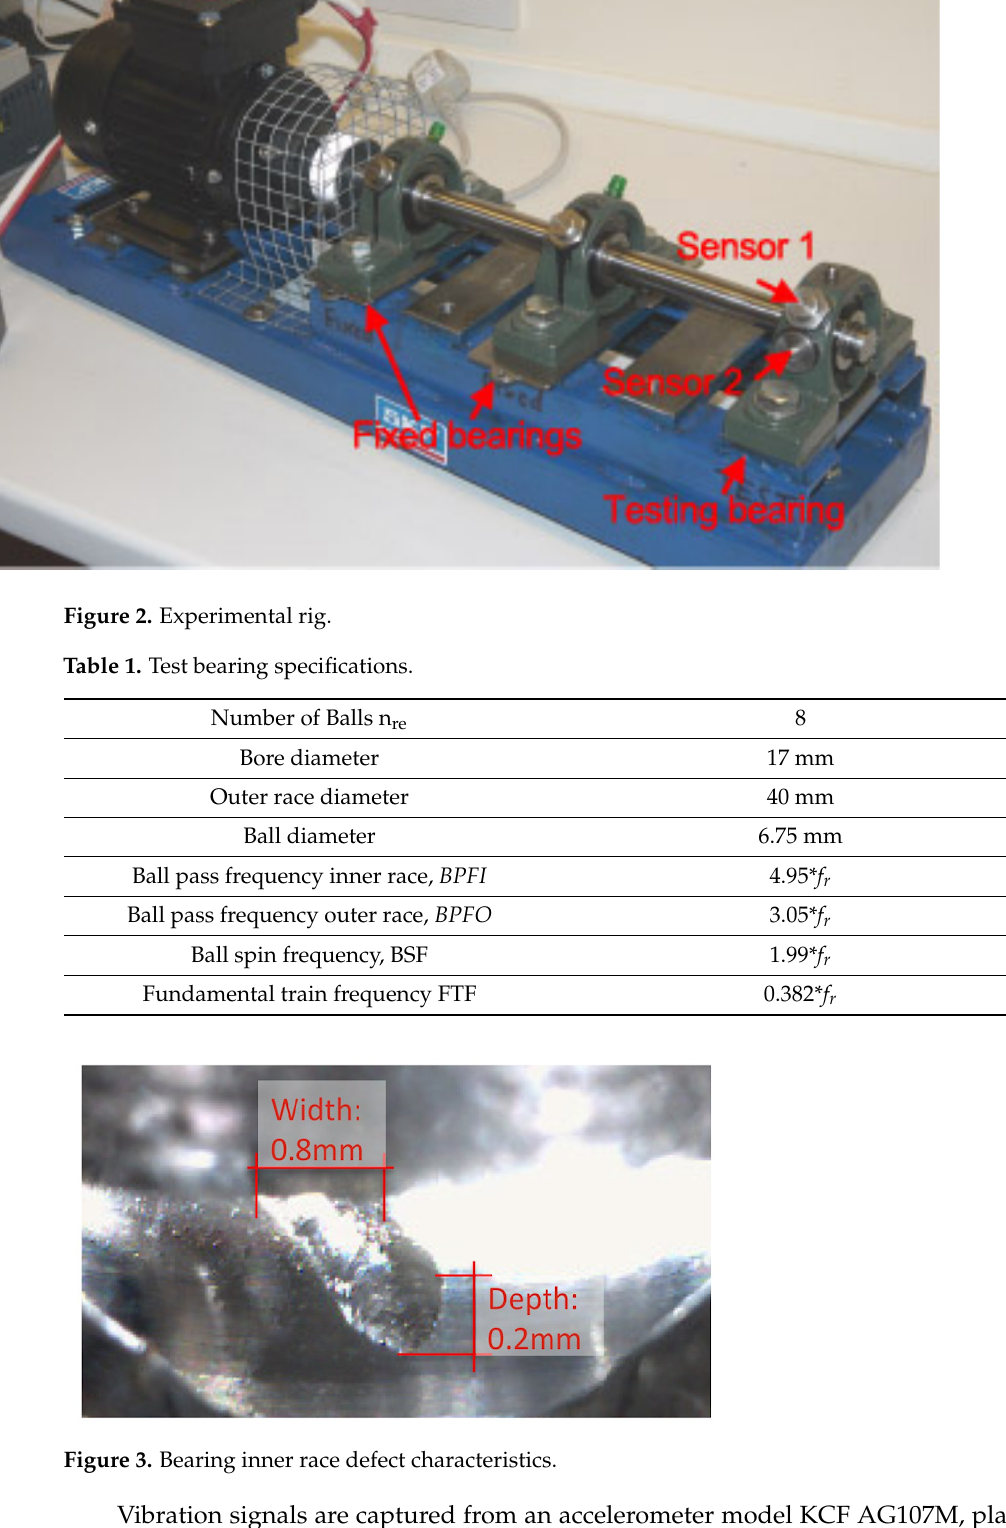
Table 2. KCF AG107M accelerometer specification.